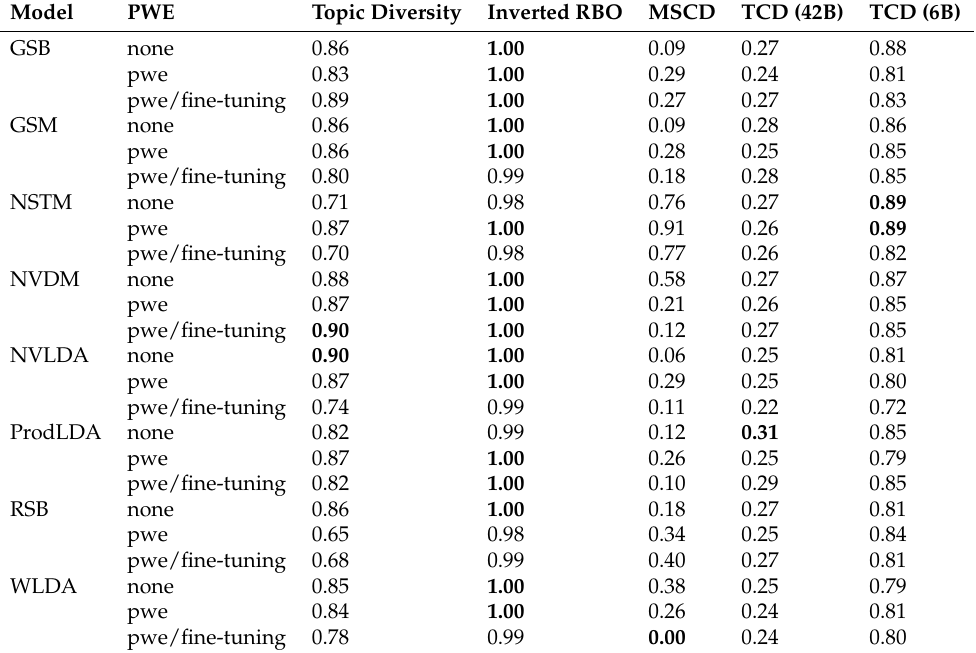
Table 16. Topic Diversity on DBLP.